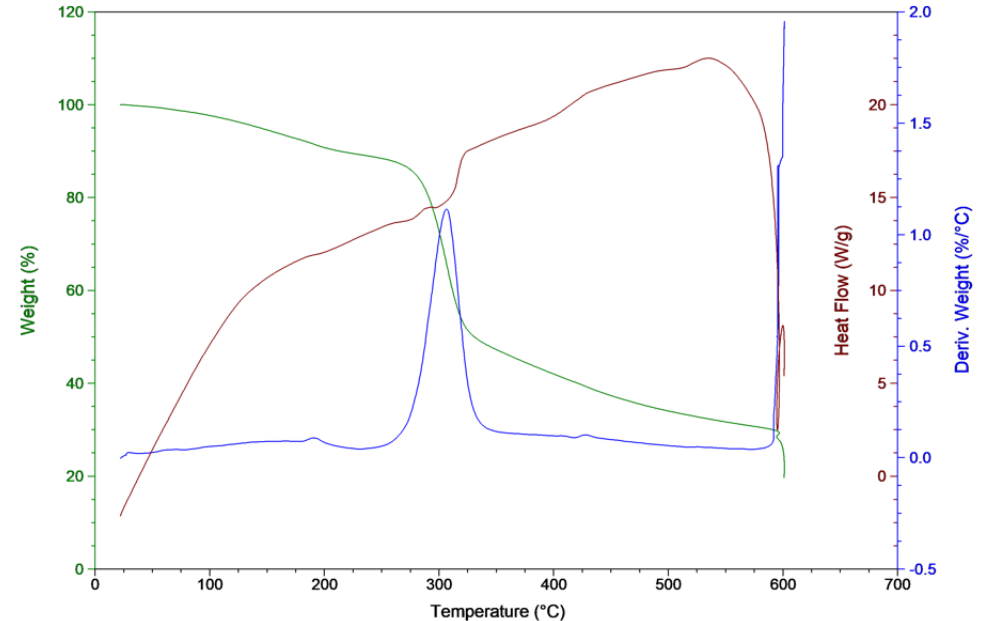
Figure 3. Thermogravimetry (TG) and DTG curves of microalgae.